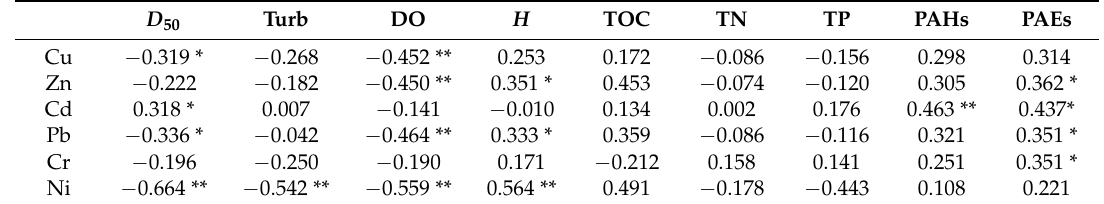
Table 2. Correlation analysis between the heavy metal concentration and environmental